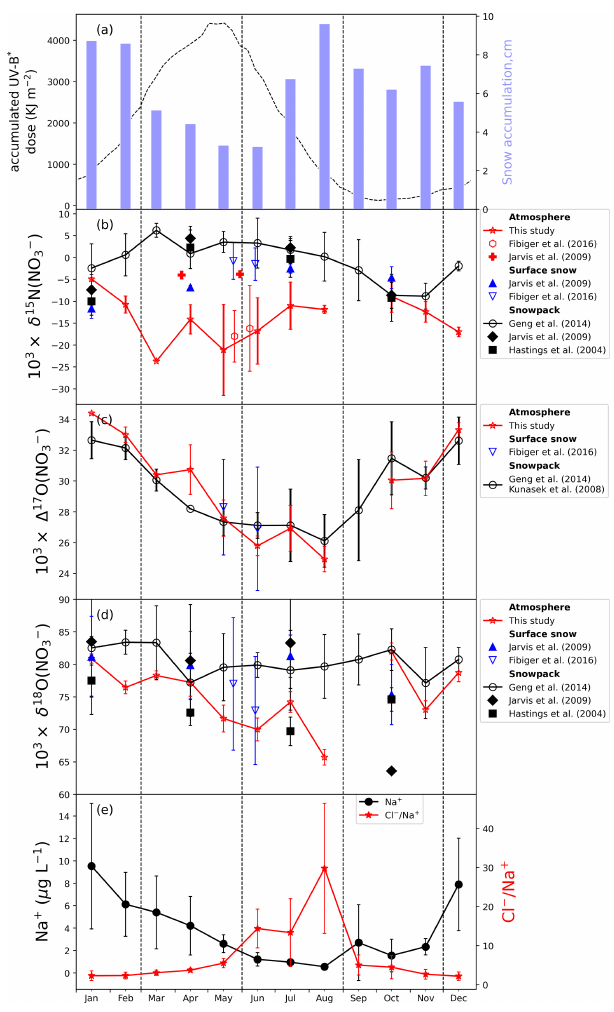
Figure 2. (a) Cumulative UV-B ∗ dose as a function of the de- posited time (dashed black line) calculated according to Eq. (2) and monthly snow accumulation in centimeters (bar plot). The cumula- tive UV-B ∗ dose represents the actinic dose that would have been experienced by snowpack nitrate deposited at different times. (b–d) Compiled monthly and/or seasonal atmospheric, surface snow and snowpack δ 15 N /(cid:49) 17 O /δ 18 O(NO − ) data at Summit, Greenland. 3 (e) Compiled monthly snowpack Na + concentration and Cl − / Na + ratio. The seasonal data (represented by the filled markers) were plotted against the central month of each season. The monthly data were represented by the hollow markers. The vertical lines represent the interval of seasons. The error bar represents 1 standard error for the monthly or seasonal mean. Data sources are summarized in Ta- ble 1. The atmospheric δ 18 O(HNO 3 ) data in Fibiger et al. (2016) and Jarvis et al. (2009) are both out of range of the snow samples, as well as our atmospheric samples, and thus are not shown